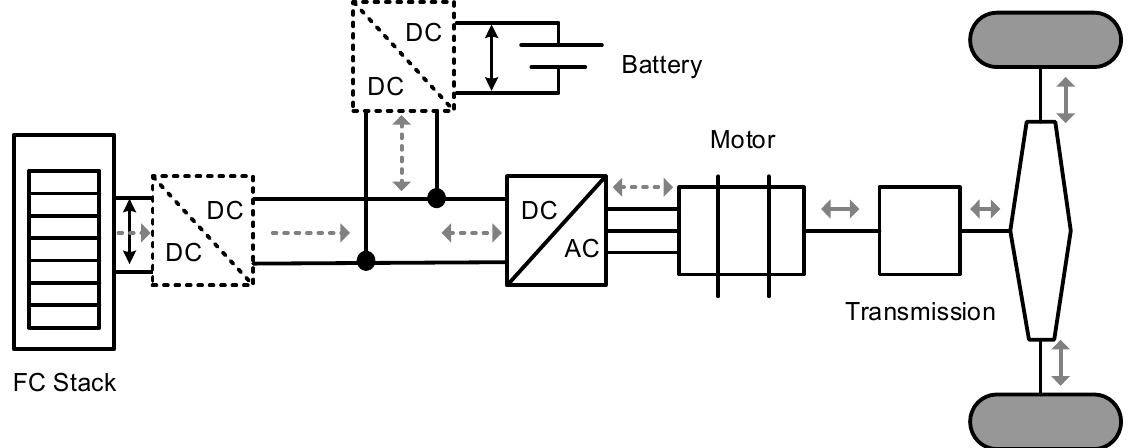
Figure 1. Structure diagram of the fuel cell electric vehicle powertrain system.